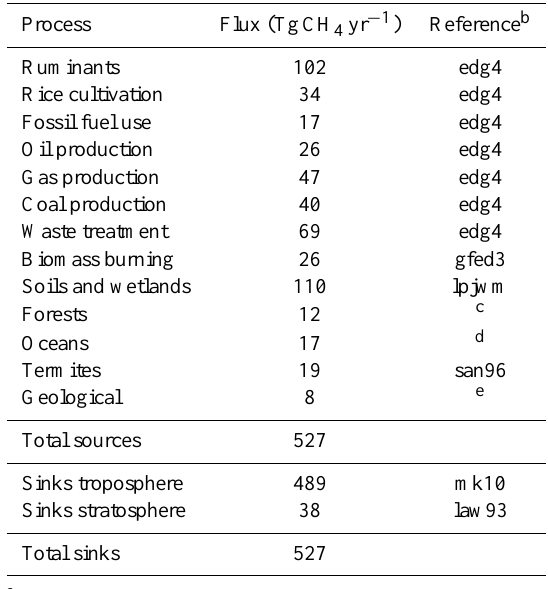
Table 1. A priori CH 4 fluxes for the year 2005 a